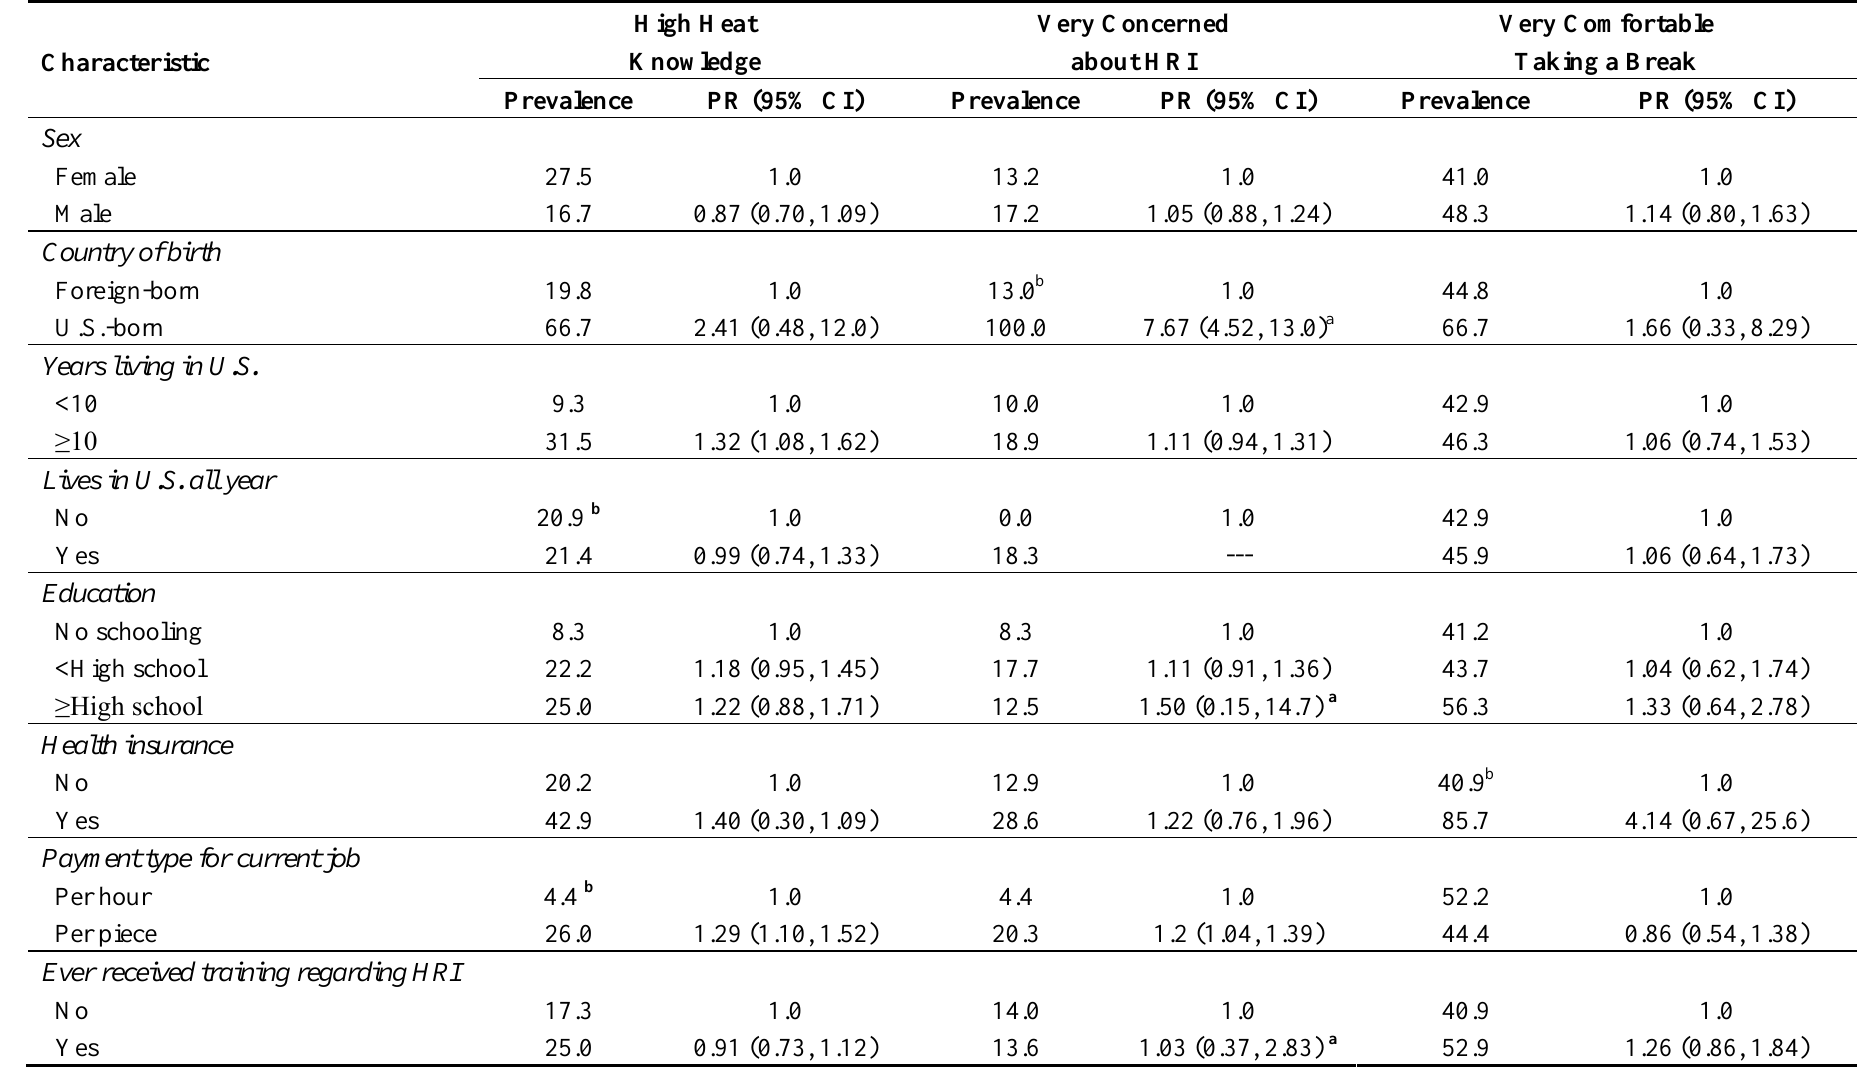
Table 4. Prevalence and prevalence ratios of high heat knowledge, level of heat-related illness (HRI) concern, and comfort level taking a break by individual and work characteristics among study participants, Oregon,